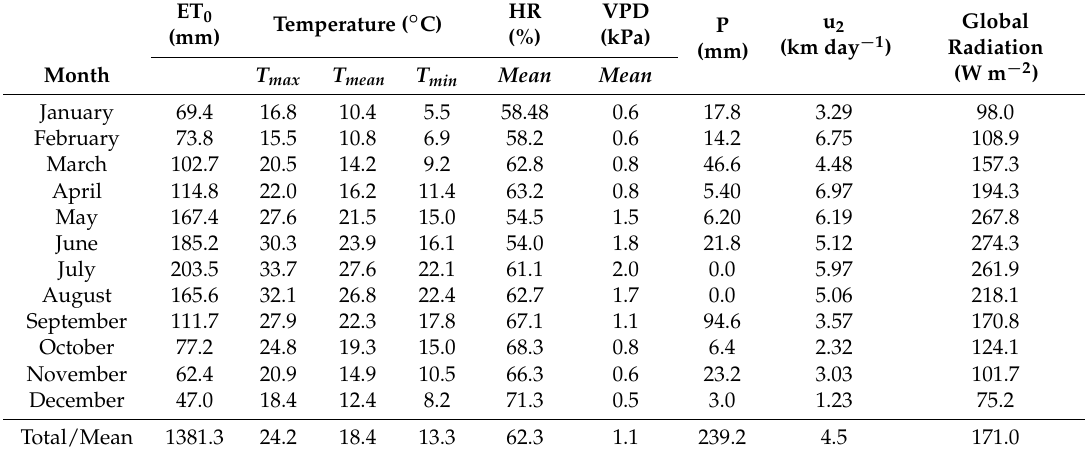
Table 2. Monthly crop reference evapotranspiration (ET 0 ); maximum, mean, and minimum air temperatures ( ◦ C); mean relative humidity (HR, %); mean vapor pressure deficit (VPD,